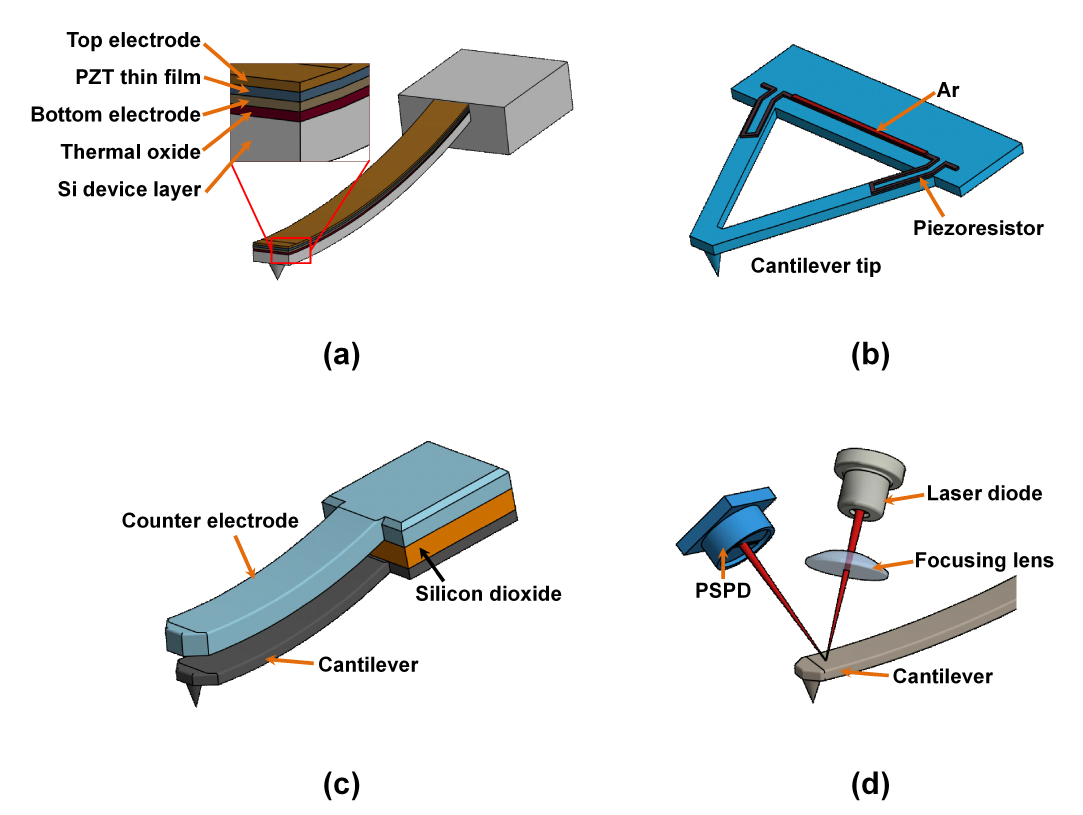
Figure 6. Schematics of ( a ) piezoelectric (adapted from [144]), ( b ) piezoresistive, ( c ) capacitive (adapted from [145]), and ( d ) optical lever microcantilever deflection detection systems